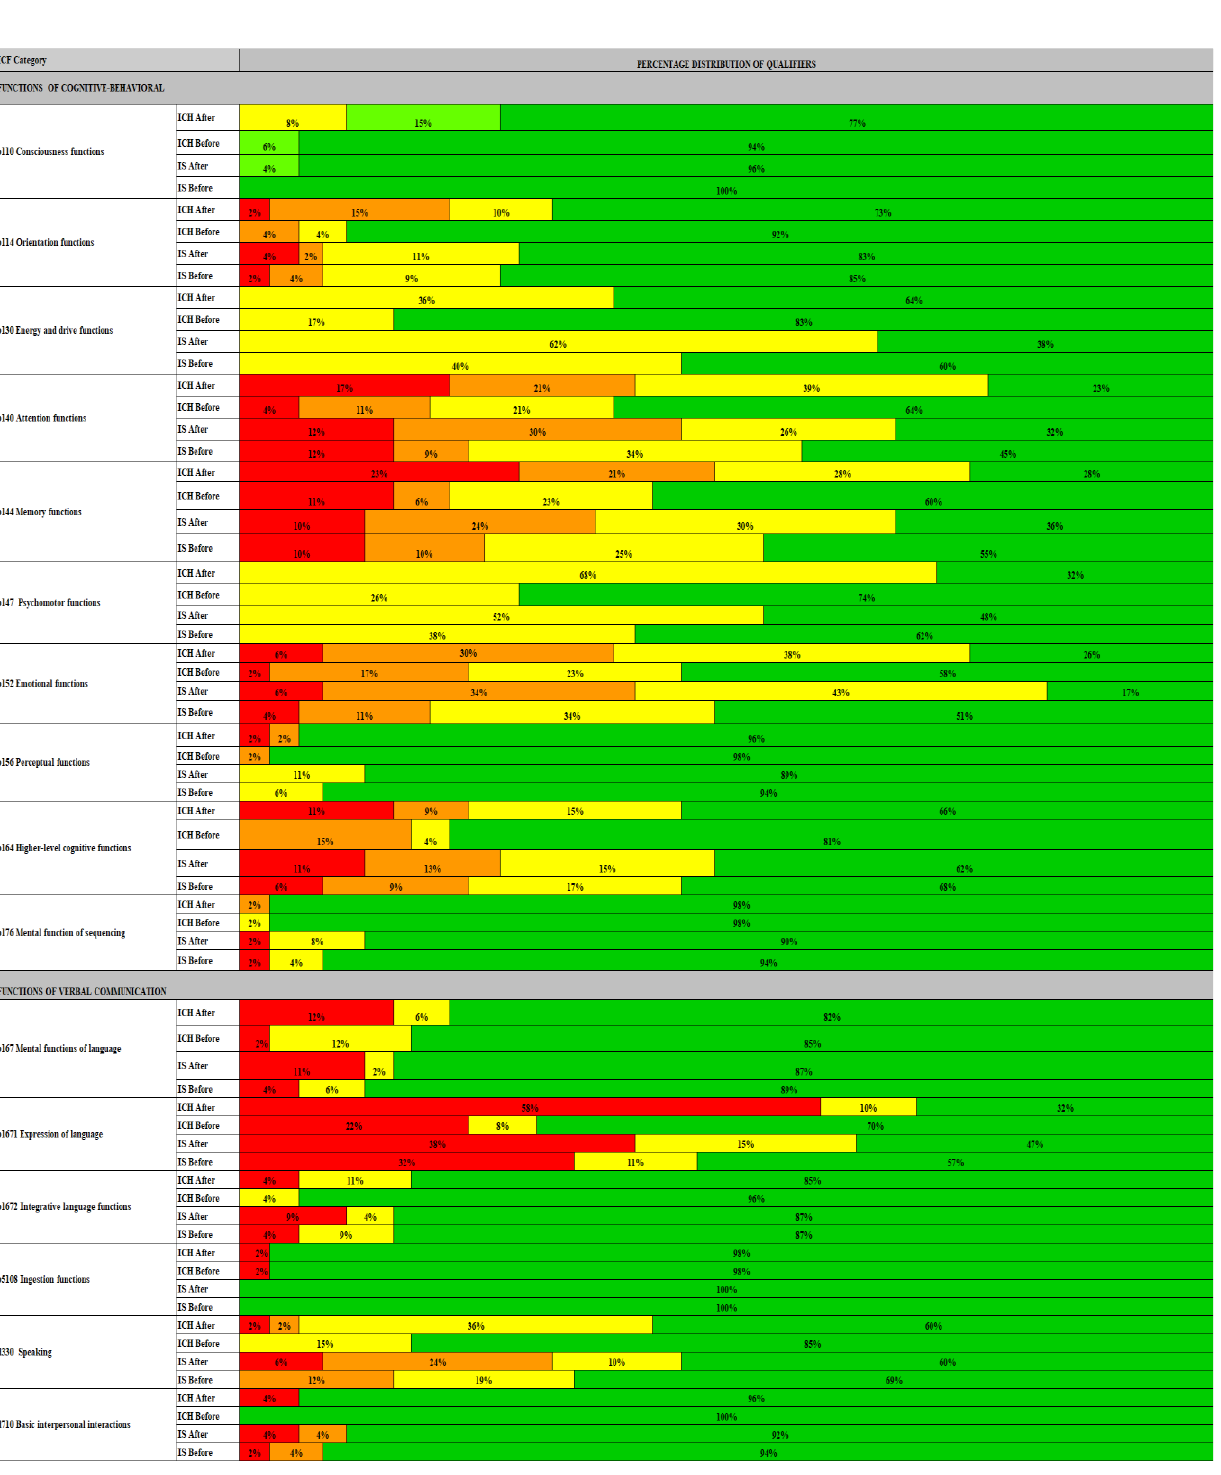
Figure 1. Profile of cognitive and speech therapy disorders according to the ICF classification cate- gories. ICH—intracerebral hemorrhage; ICF—International Classification of Functioning, Disability and Health; IS—ischemic stroke; Red color—extremely high occurrence of disturbance; Orange color—significant occurrence of the disorder, Yellow color—moderate occurrence of the disorder; Light green color—significant occurrence of disturbance; Dark green color—no disorder